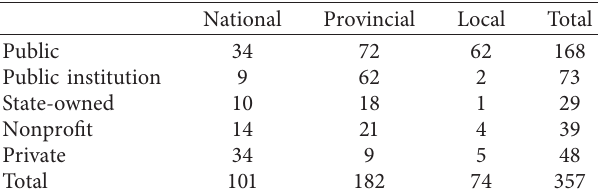
Table 2: Number distribution of interacting organizations by level of jurisdiction and source of